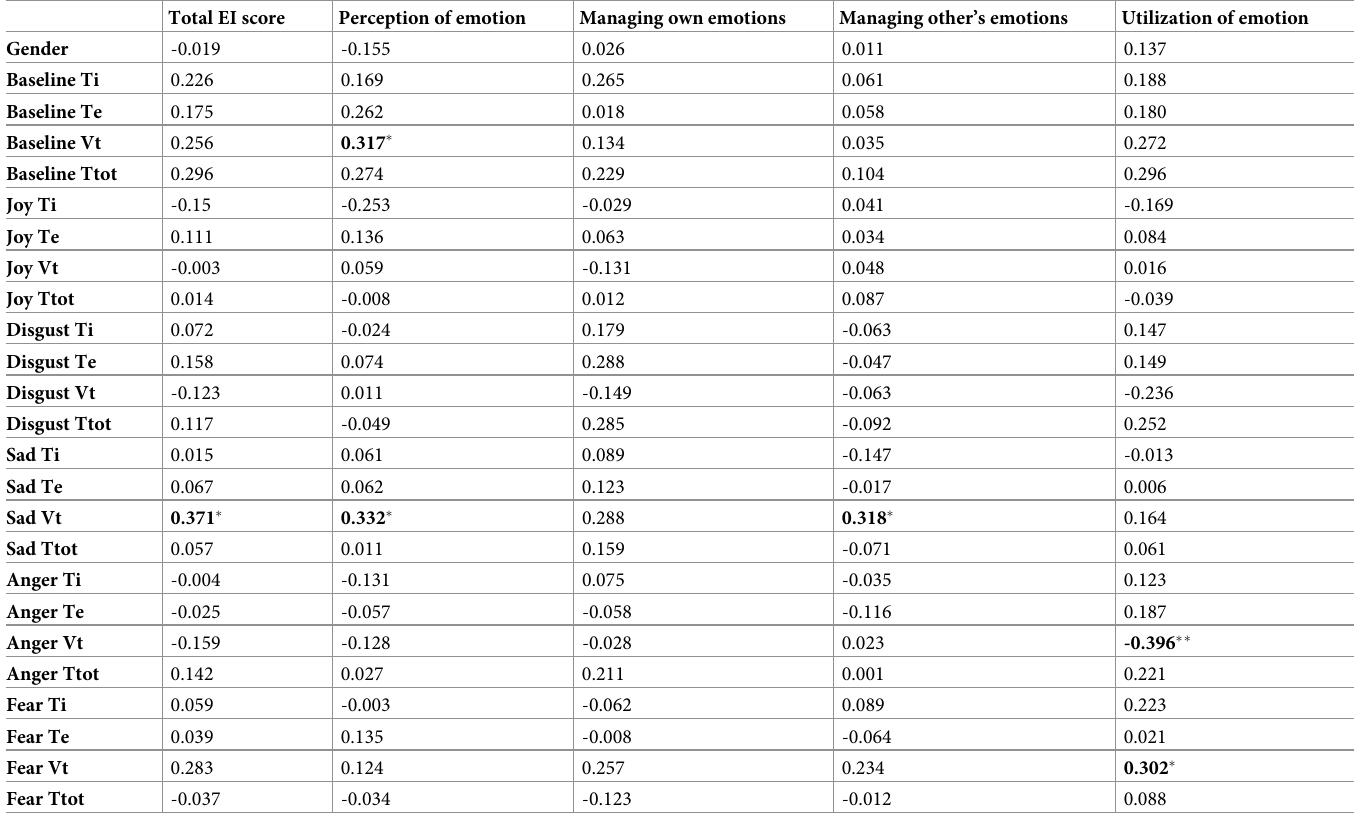
Table 12. Pearson correlations between cardiac reactivity parameters and emotional intelligence scores.